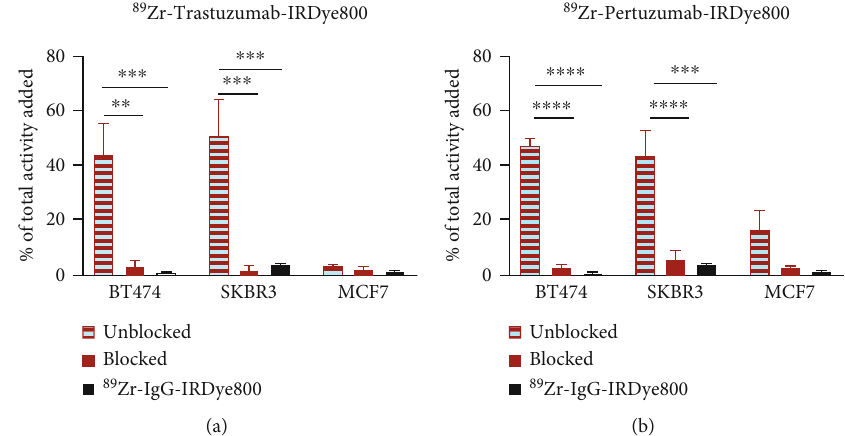
Figure 2: Quantitative assessment of HER2 binding with dual-labeled anti-HER2 immunoconjugates. Radioactive uptake of dual-labeled trastuzumab (a) and pertuzumab (b) correlated with HER2 expression and was blocked with a 100-fold excess of the corresponding naked mAb. Data are presented as the mean ± SD . ∗∗ P < 0 : 01 , ∗∗∗ P < 0 : 001 , and ∗∗∗∗ P < 0 : 0001 .